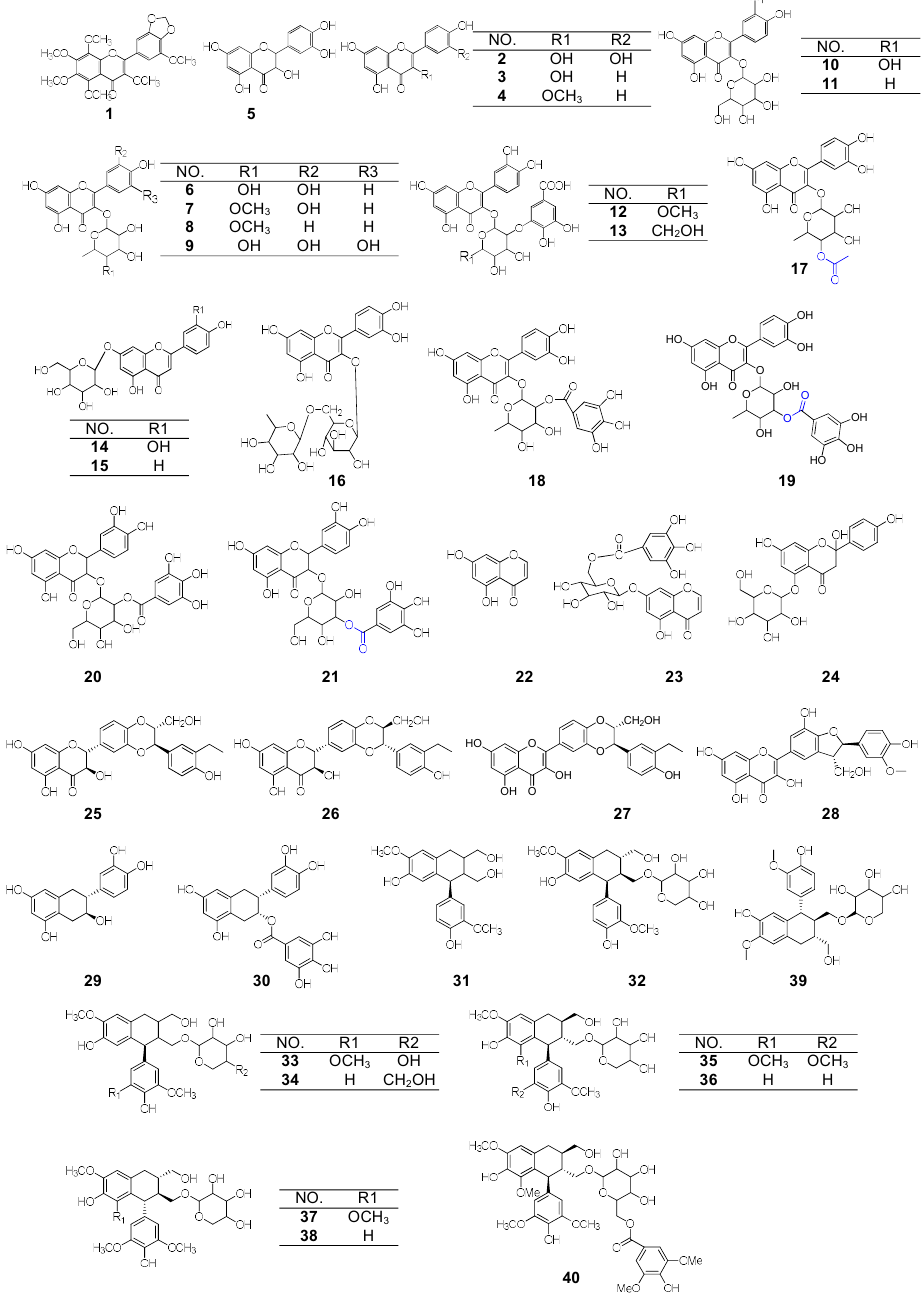
Figure 1. The chemical structure of compounds from P. capitatum .